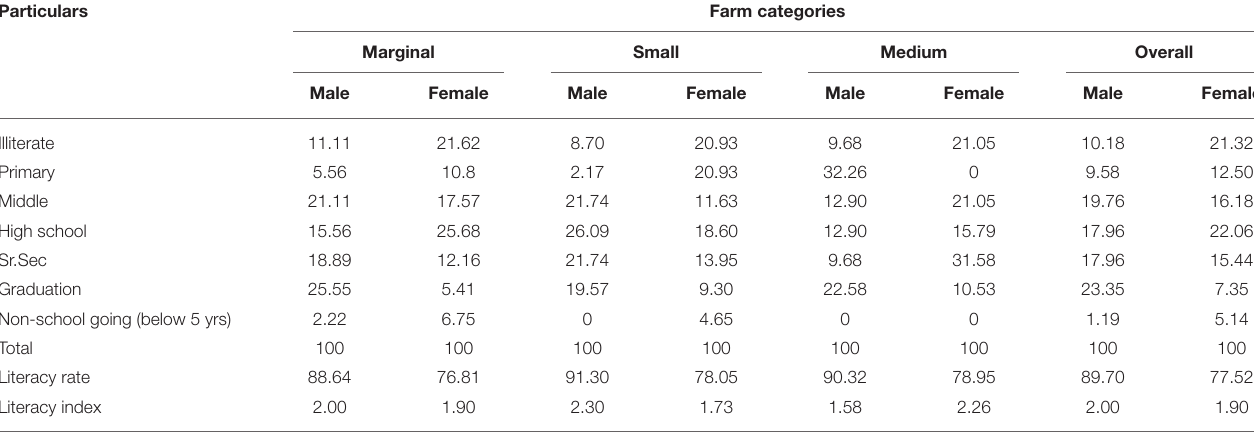
TABLE 4 | Farm category-wise literacy status of sampled households (%).